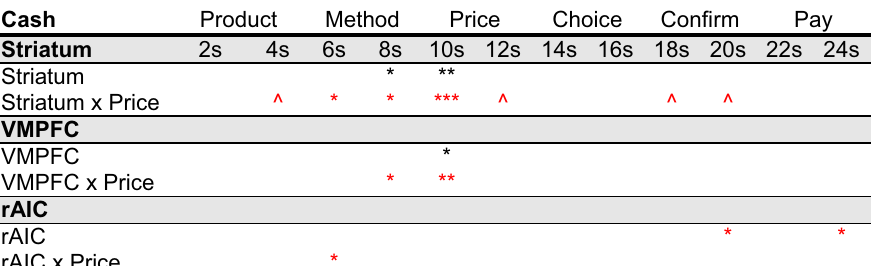
Figure 5. Above: y-axis plots the difference between average purchase and average non-purchase ROI signal intensity, for high-price (black) and low-price (grey) items by payment method. Below: Buy decision regressed on ROI signal intensity and the interaction between price (continuous) and ROI signal intensity at each TR, separately for credit and for cash. Red indicates a negative coefficient. Parameter significance denoted by *** p < .001, ** p < .01, * p < .05, ^ p <